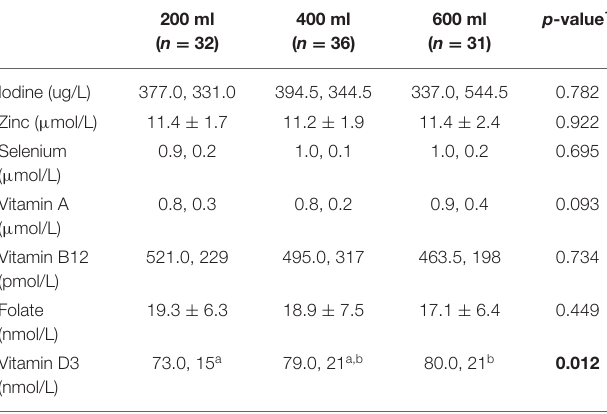
1 The p-value represents the outcome of the ANCOVA, controlling for baseline values. Superscripts a , b indicate differences between intervention groups.